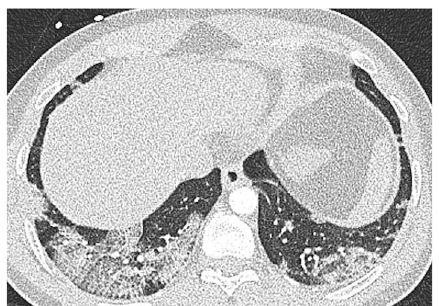
Figure 4. 40-year-old non-vaccinated male patient with a typical crazy-paving pattern, well appreciated in the right lower lobe.